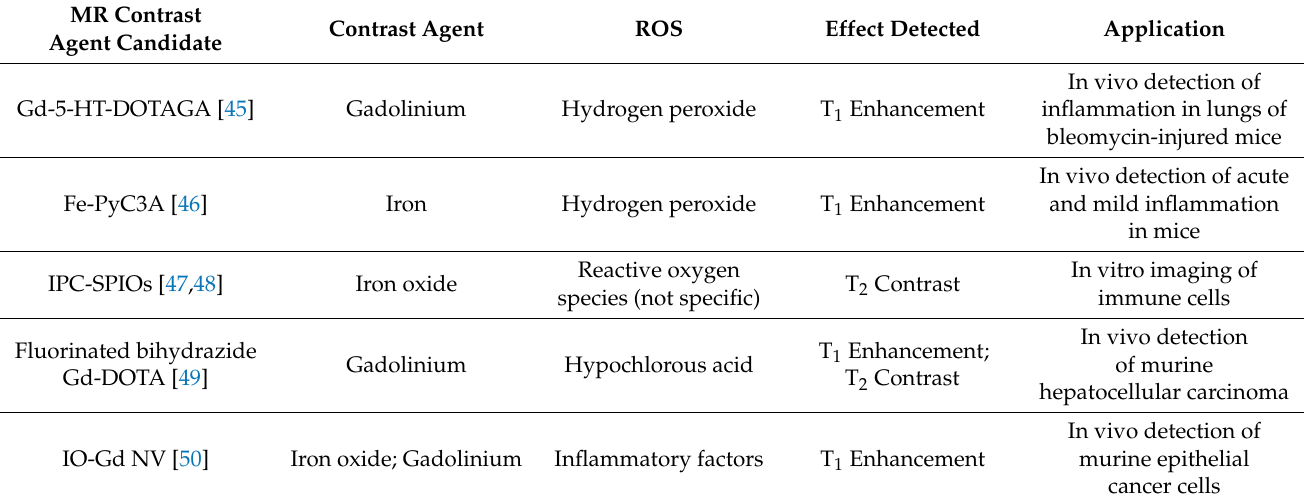
Table 2. Reactive oxygen species (ROS)-sensitive contrast